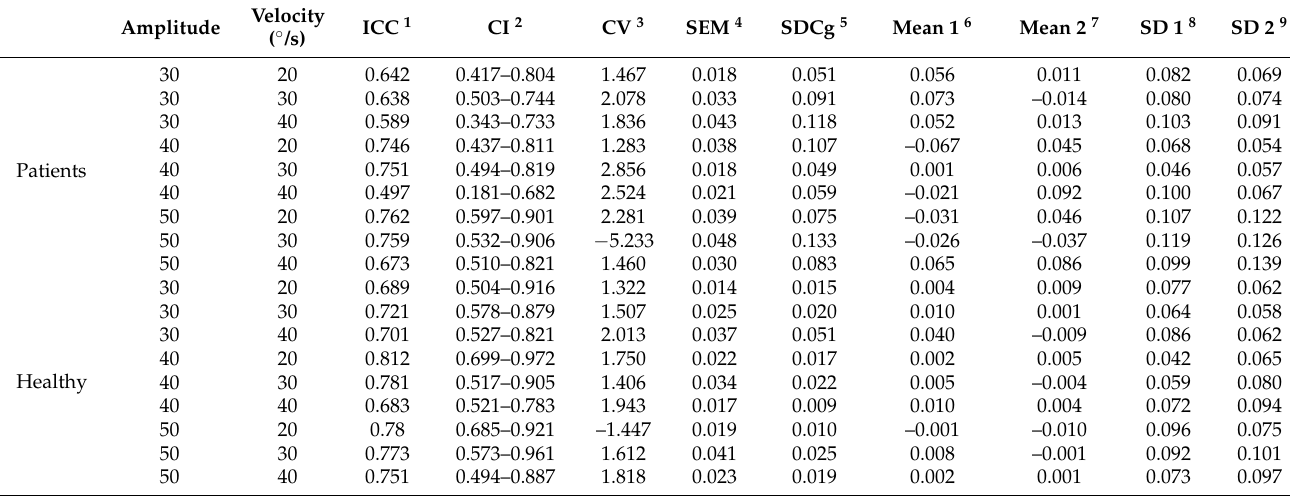
Table 3. Reliability of smooth pursuit neck torsion difference for both